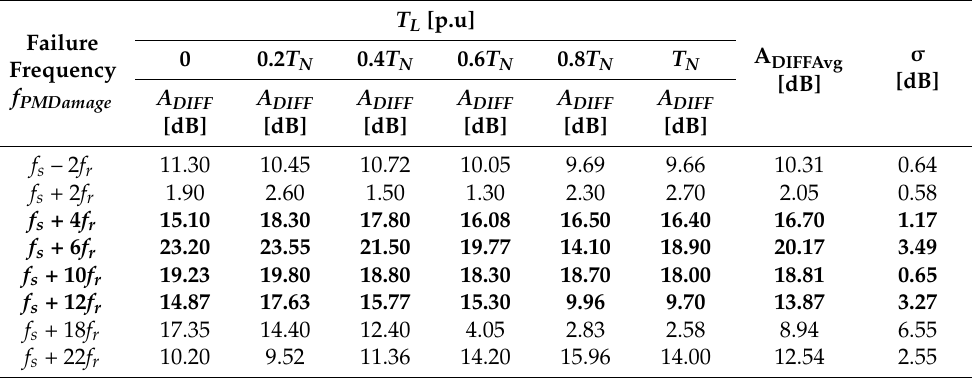
Table 1. The analysis of amplitude increases of the selected frequency components characteristic of the PM fault for different load torques.